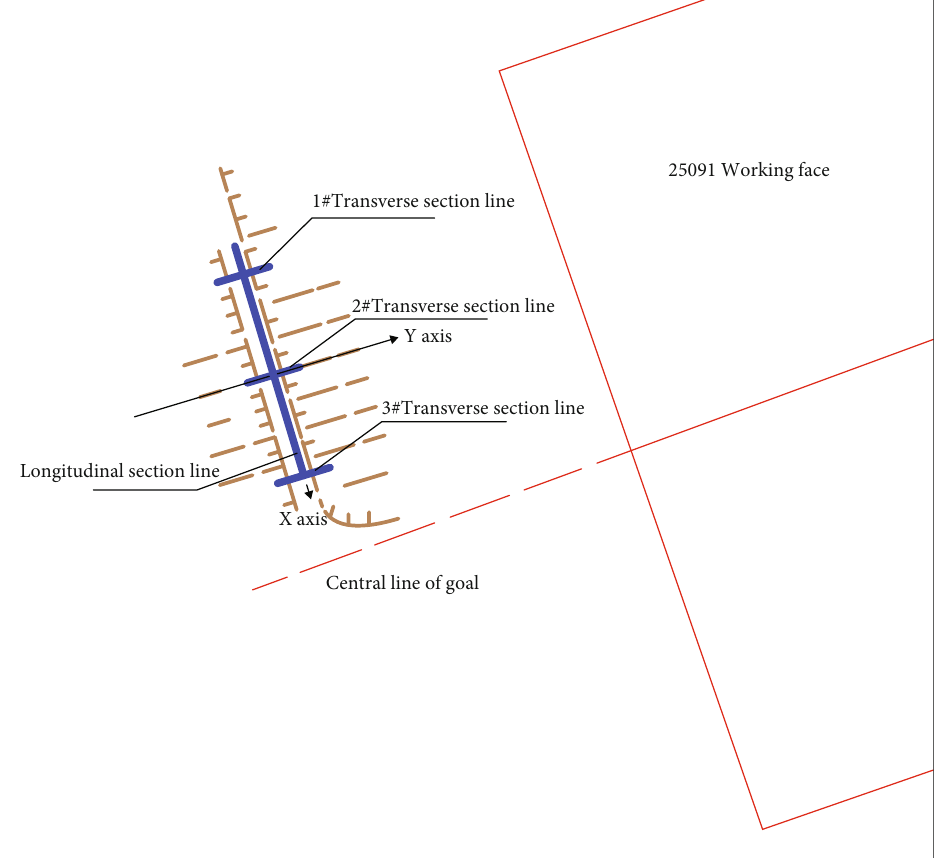
Figure 13: Section line in the dam relative to working face.